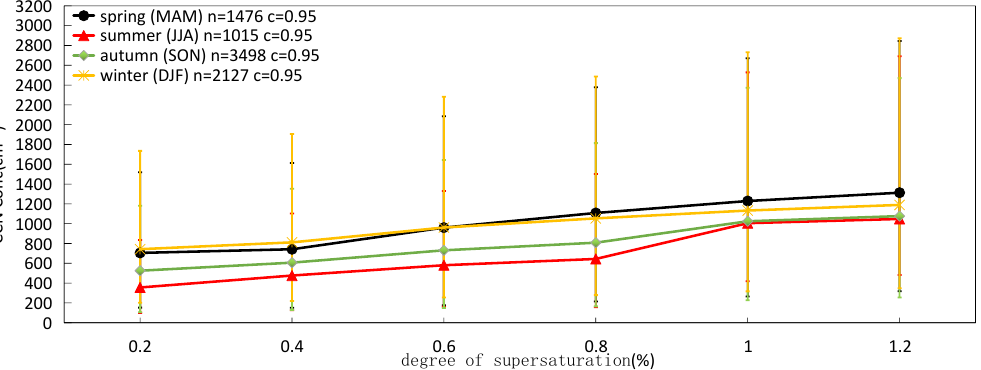
Figure 5. Seasonal variation in CCN concentration under different degrees of supersaturation in LPS.